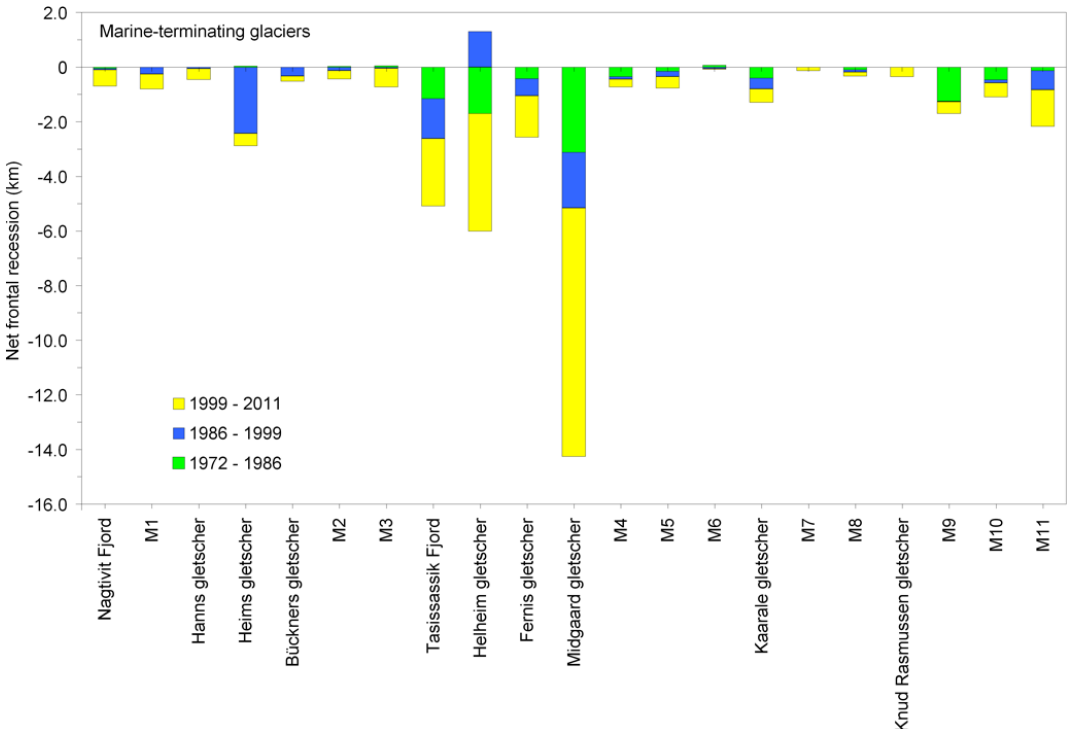
Fig. 4. Satellite-derived net frontal recession for the 21 marine-terminating glaciers in the Ammassalik region for the sub-periods 1972–1986 (green), 1986–1999 (blue), and 1999–2011 (yellow). For glacier locations, see Fig.